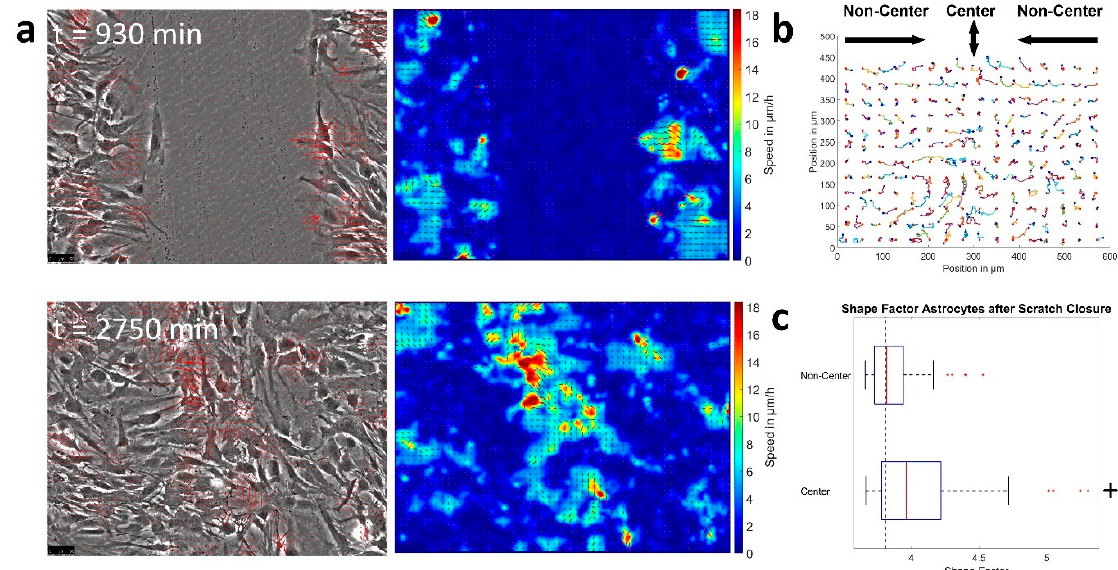
Figure 4. Behavior of astrocytes after wound closure. ( a ) Shows phase contrast images of astrocytes subjected to a scratch at different time points after the injury, overlaid with the velocity vectors (left). The right part shows the local speed and its direction. ( b ) Depiction of the movement paths taken by the cells of ( a ) after scratch closure. Red dots denote the start and blue dots the end position. ( c ) Illustration of the difference in shape factor for two distinct regions (see ( b )) of the wound healing assay after scratch closure. The dotted line shows the critical value of 3.81 predicted by the vertex model. Below cells are considered to be jammed. “+” depicts if shape factors are significantly larger or smaller than the critical value with p = 0.049, as tested by sign test for 61 or 85 cells at the center or in the non-center region. Box plots show the median (red line), 25 and 75 percentile (box), non-outlier range (whiskers) and outliers (red dots).